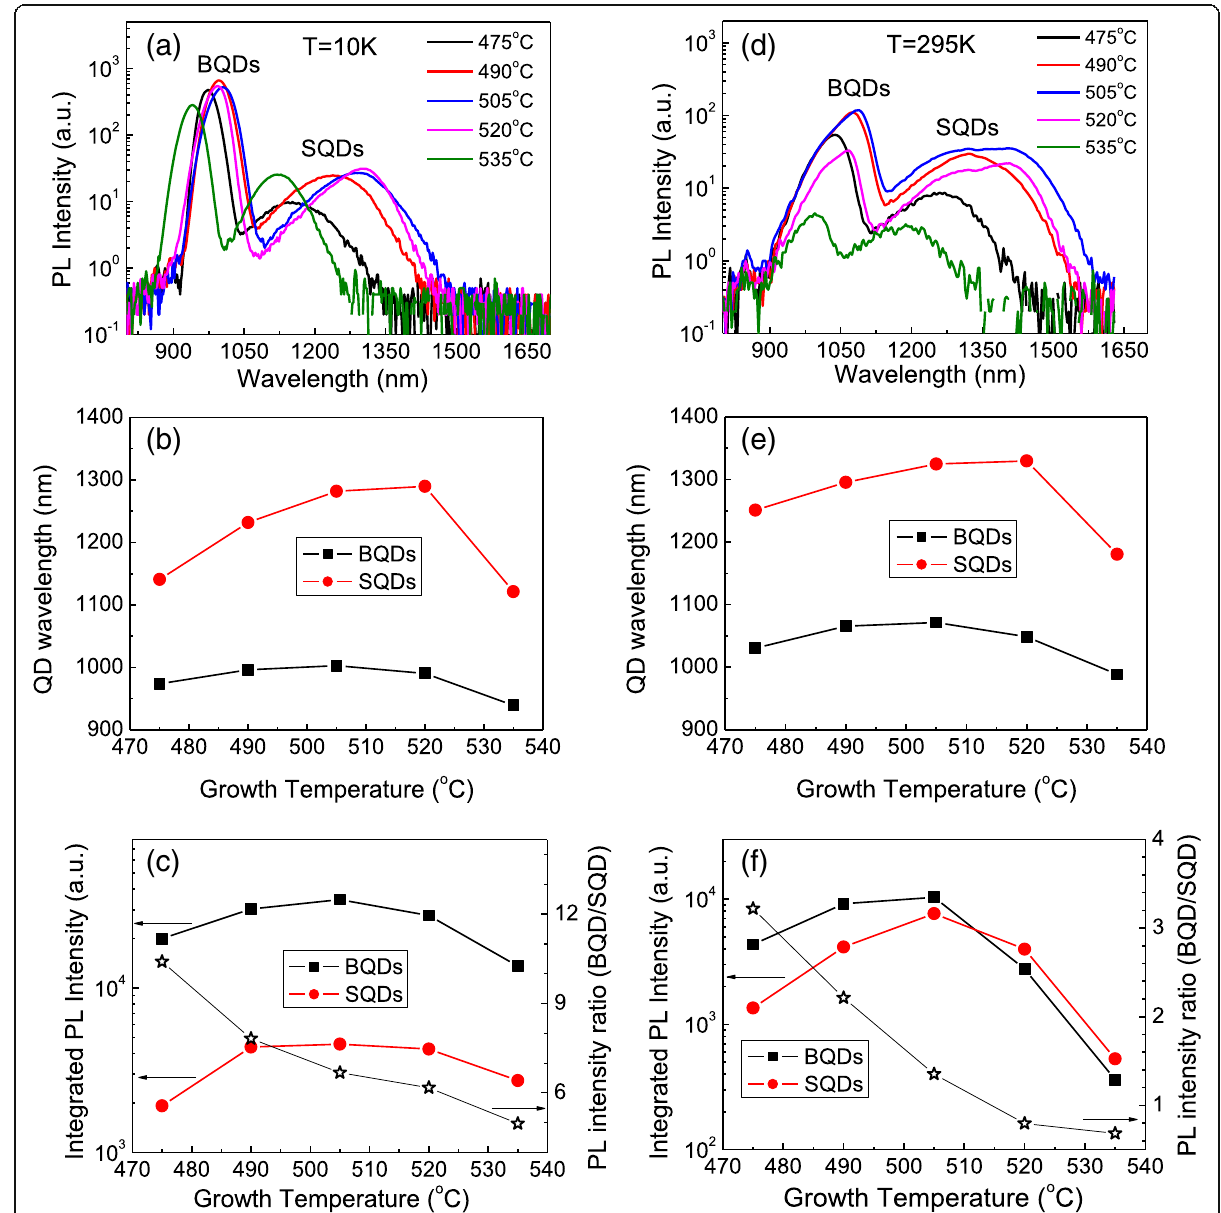
Fig. 2 a PL spectra measured at 10 K with an excitation laser intensity of 20 W/cm 2 . b Extracted PL wavelength and c integrated PL intensity as a function of the growth temperature. d PL spectra measured at 295 K with an excitation laser intensity of 200 W/cm 2 . e PL wavelength and